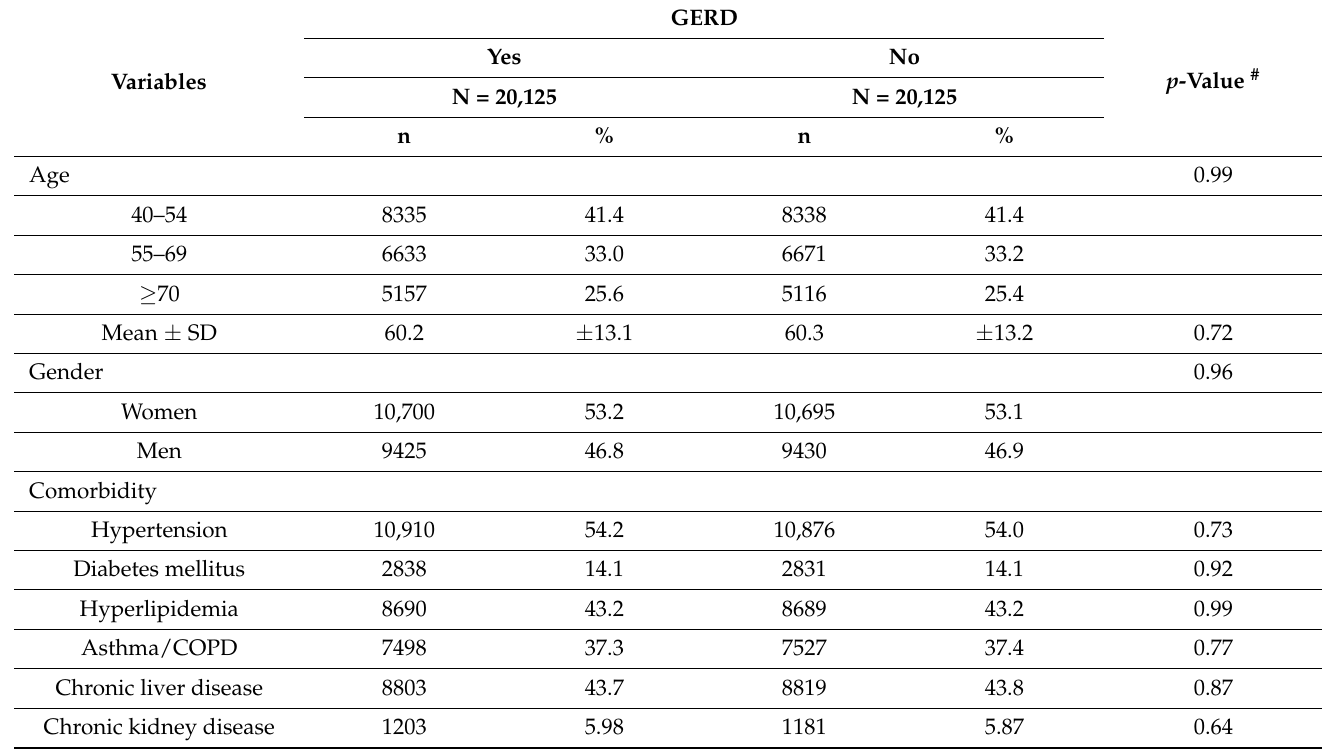
Table 1. Demographic characteristics and comorbidities for individuals with and without